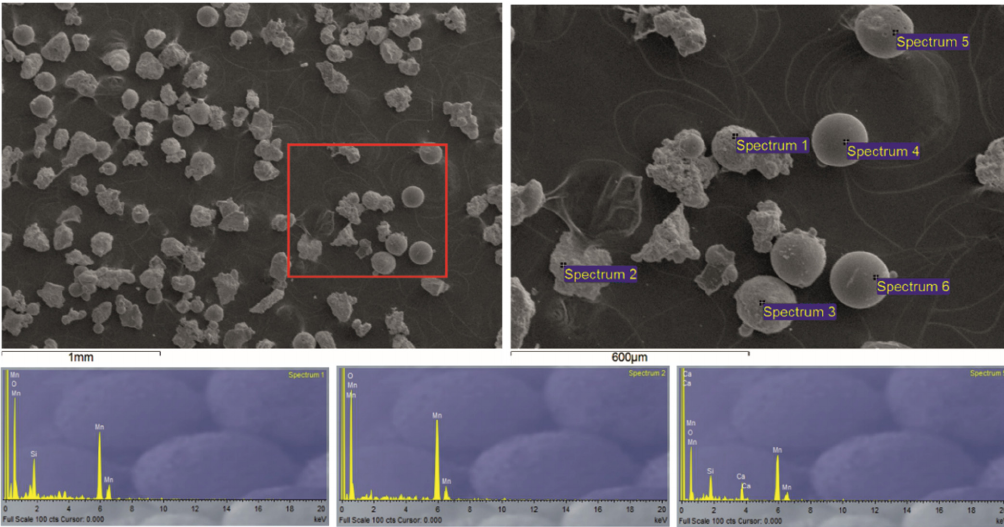
Figure 5. Backscattered electron images of the heavy dust fraction and EDS spectra of the selected grains.